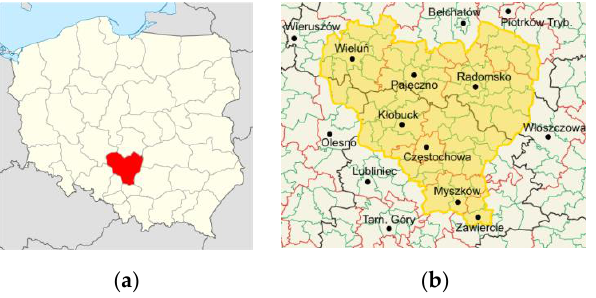
Figure 1. Archdiocese of Czestochowa on the map of Poland ( a ); the map of Archdiocese ( b ) (https://commons.wikimedia.org/wiki, accessed on 20 August